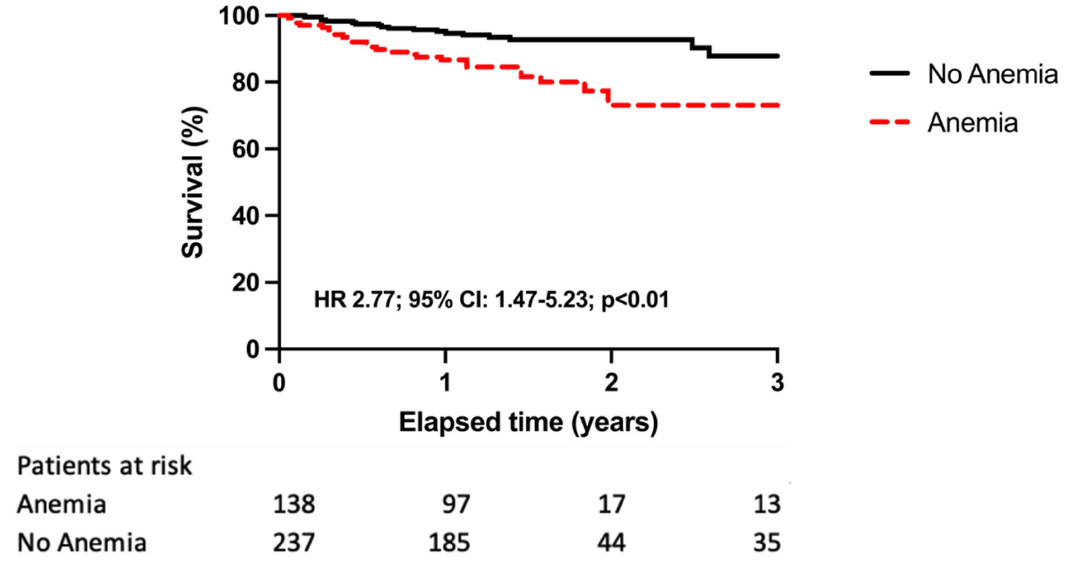
Figure 2. Kaplan–Meier estimates of the probability of survival according to the presence vs. absence of anemia.